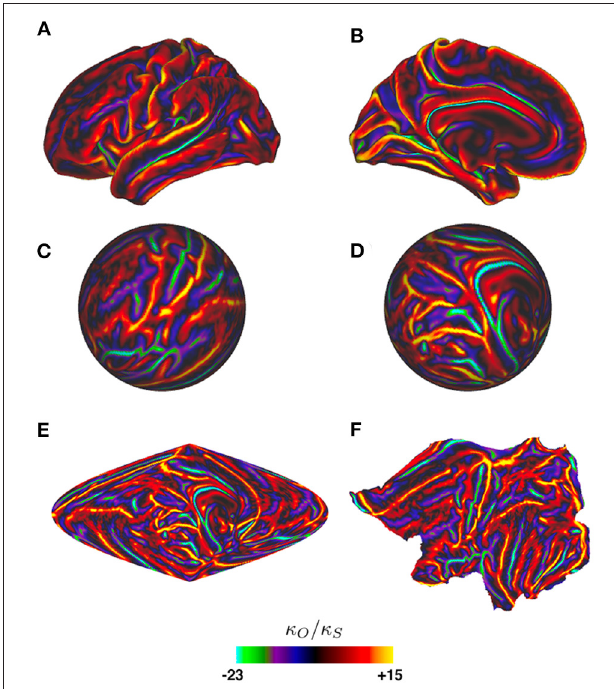
FIGURE 8 | Ratio κ O /κ s of one cortical hemisphere’s local curvature to that of an equal-area sphere vs. position, as indicated by the color bar. Surfaces are of an average cortical template from the Human Connectome Project ( Glasser et al., 2016 ). (A) Lateral view of the hemisphere. (B) Medial view. (C) Spherical projection corresponding to (A) , mapped to spherical coordinates via the standard Freesurfer mapping ( Fischl et al., 1999). (D) Spherical projection corresponding to (B) . (E) Sinusoidal projection of the whole hemisphere. (F) Flat projection of the hemisphere ( Fischl et al., 1999).